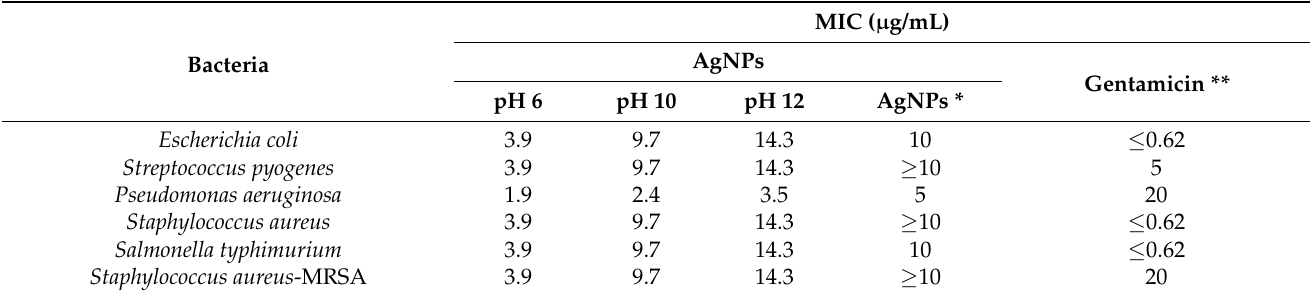
Table 2. Antibacterial activity of AgNP synthesized with cell suspension culture extracts of Randia aculeata L. at different pH